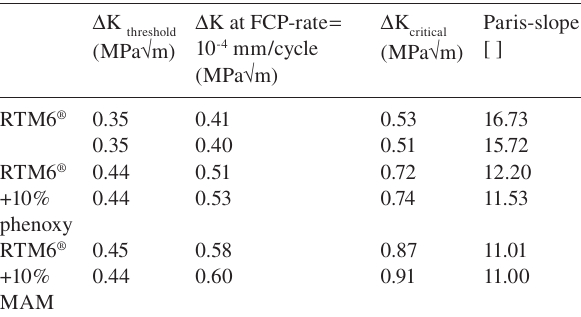
Table 2 Summary of characteristic ∆ K values obtained from FCP-